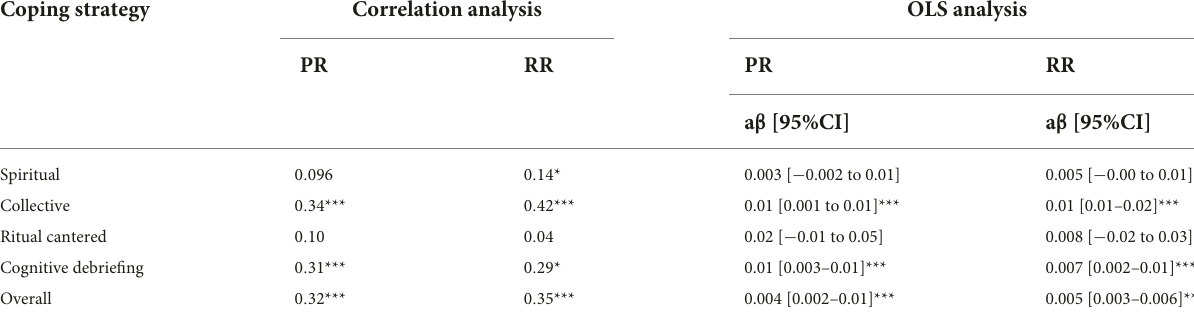
TABLE 3 The influence of coping strategies on resilience among the participants.